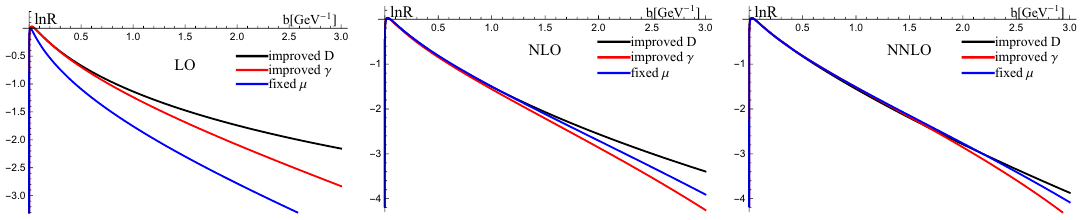
Figure 7 . Comparison of evolution exponents evaluated in di(cid:11)erence schemes. The (cid:12)nal point of evolution is ( (cid:22) f ; (cid:16) f ) = ( M Z ; M 2 ). The initial point is ( (cid:22) i ; (cid:16) (cid:22) ) at (cid:22) i = C 0 =b + 2. The (cid:12)xed (cid:22) - Z i solution indicates the solution (6.13) with no initial point of evolution. The anomalous dimension D is taken in the resummed form (A.3). No non-perturbative modi(cid:12)cations of D are made.